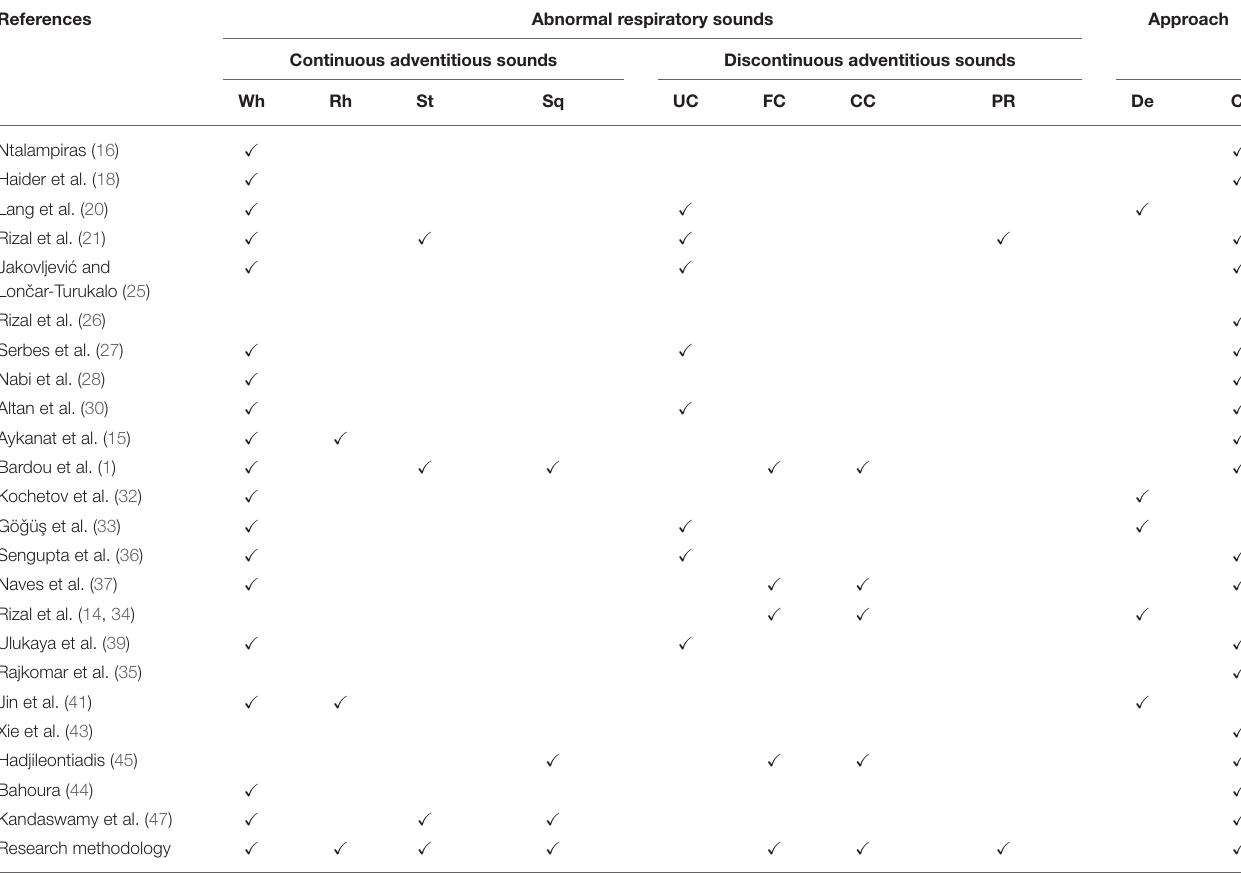
TABLE 1 | Comparison and overview of exiting “ARS”